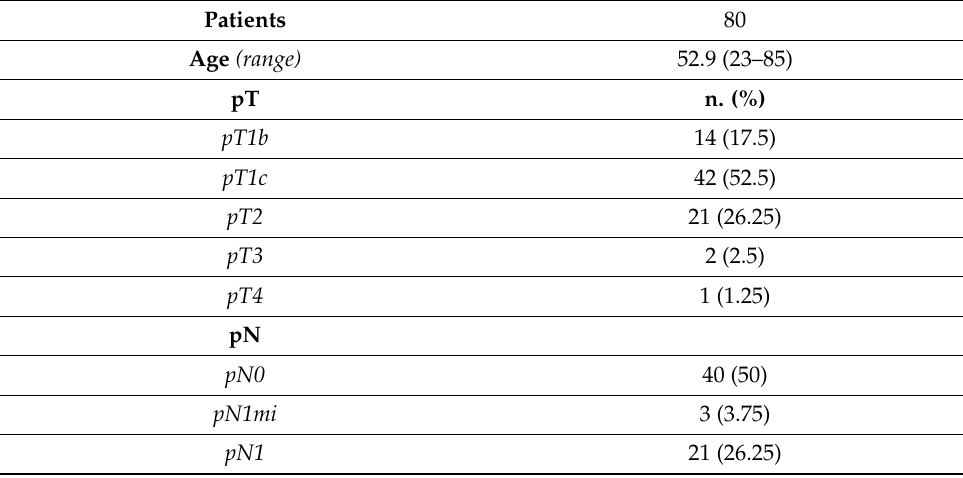
Table 1. Clinicopathological characteristics of